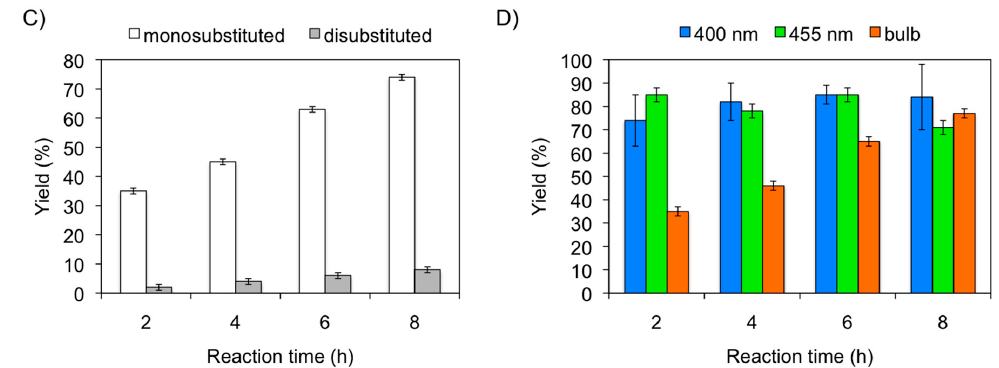
Figure 1. Effect of light source on the yield and product distribution of a trifluoromethylation model reaction in gel medium. Irradiation source: ( A ) LEDs ( λ ex = 400 nm); ( B ) LEDs ( λ ex = 455 nm); ( C ) CFL (bulb). Reaction conditions: 1,3,5-Trimethoxybenzene (16.8 mg, 0.1 mmol), sodium triflate (62.4 mg, 0.4 mmol), EtOAc (0.8 mL), diacetyl (0.2 mL), G-1 ( c = 20 g L − 1 ), light irradiation, air, RT. ( D ) Overall yield ( 2 + 3 ) obtained with different irradiation sources. Yields were calculated by 19 F-NMR using hexafluorobenzene (11.5 µL, 0.1 mmol) as internal standard. Monosubstituted product = 2 ; disubstituted product = 3 . Table 2. Influence of LMW gelator and gelator concentration on the yield and product distribution of trifluoromethylation model reaction. 1.